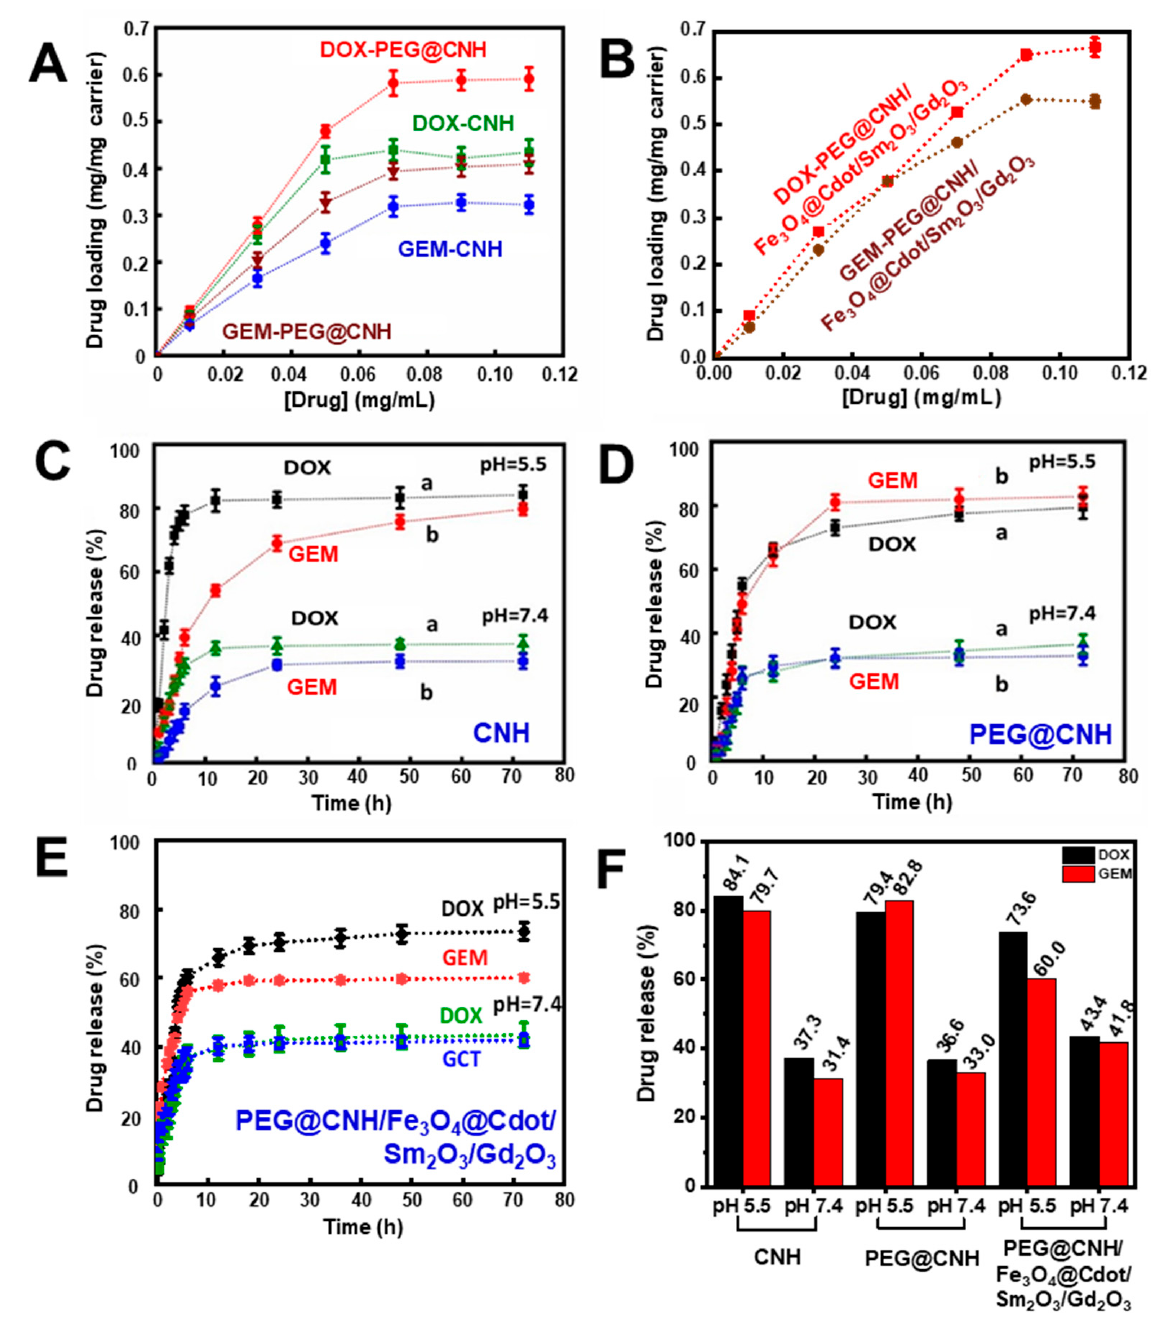
Figure 5. (a) DOX and (b) GEM loading on ( A ) CNH, PEG@CNH, and ( B ) PEG@CNH/Fe 3 O 4 @Cdot/Sm 2 O 3 /Gd 2 O 3 . (a) DOX and (b) GEM release from ( C ) CNH, ( D ) PEG@CNH, and ( E ) PEG@CNH/Fe 3 O 4 @Cdot/Sm 2 O 3 /Gd 2 O 3 . ( F ) Comparison of drug release profile. Released GEM and DOX from carriers were investigated at pH 5.5 and 7.4 for tumor and physiological pH, respectively [45]. The release amounts of drugs increased rapidly till 24 h and converged (Figure 5C–E). As compared in Figure 5F, amounts released after 72 h were almost consistent between DOX and GEM, being almost independent of carriers, but the release at the tumor environment (pH 5.5) was about 2-fold higher than at physiological pH (7.4). This pH dependence of drug release is preferable as the activity of drugs on the tumor therapy since a higher release was obtained at pH 5.5 rather than at pH 7.4. At acidic conditions (pH 5.5), the protonation of COO − groups on CNH breaks the